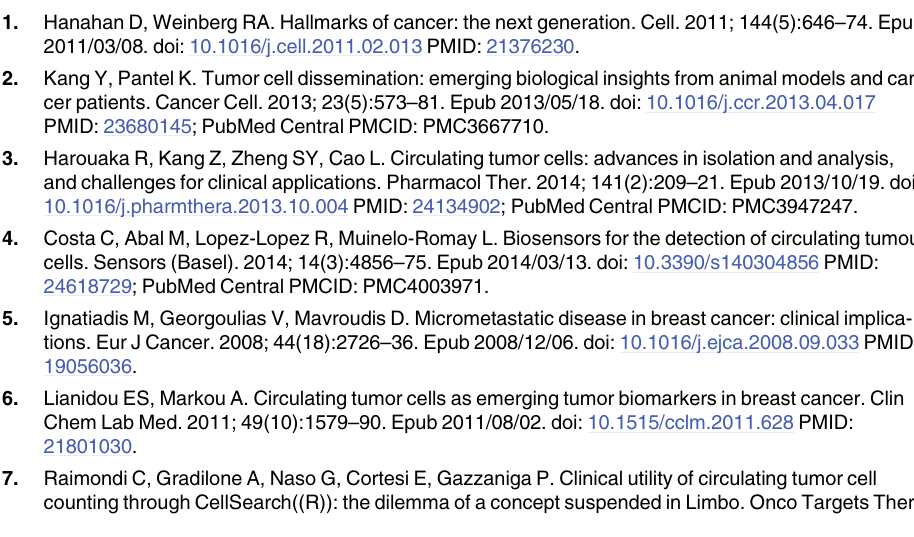
S1 Table. Characteristicsof human tumor cell